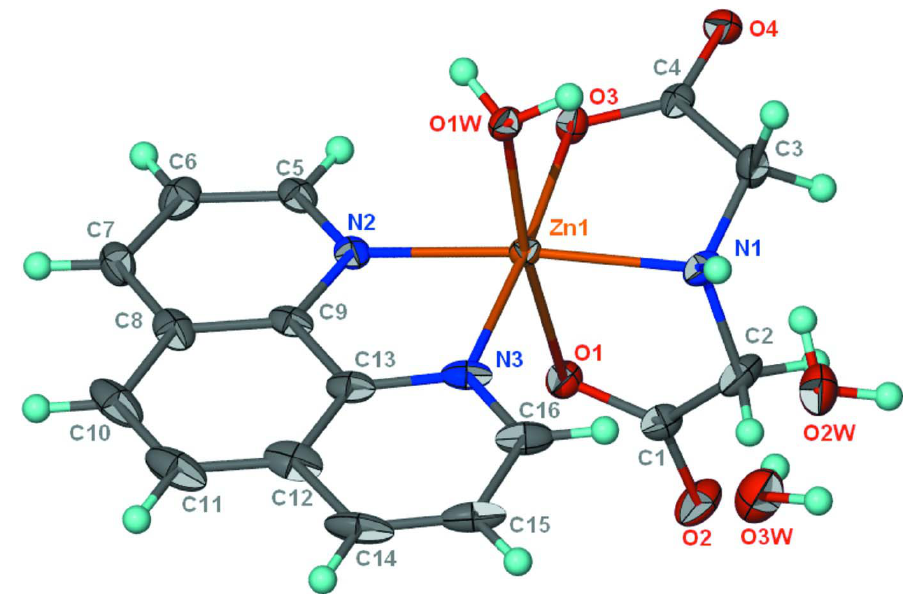
O)(C H NO )(C H N ) . 1.5H O at the 70% probability level. Hydrogen 2 4 5 4 12 8 2 2